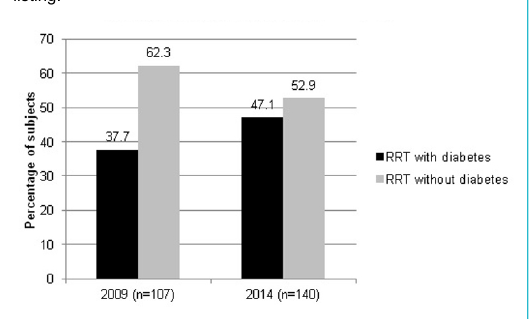
Figure 1: Percentage of subjects on renal replacement therapy (RRT) in the Canton of Vaud with and without diabetes on day of